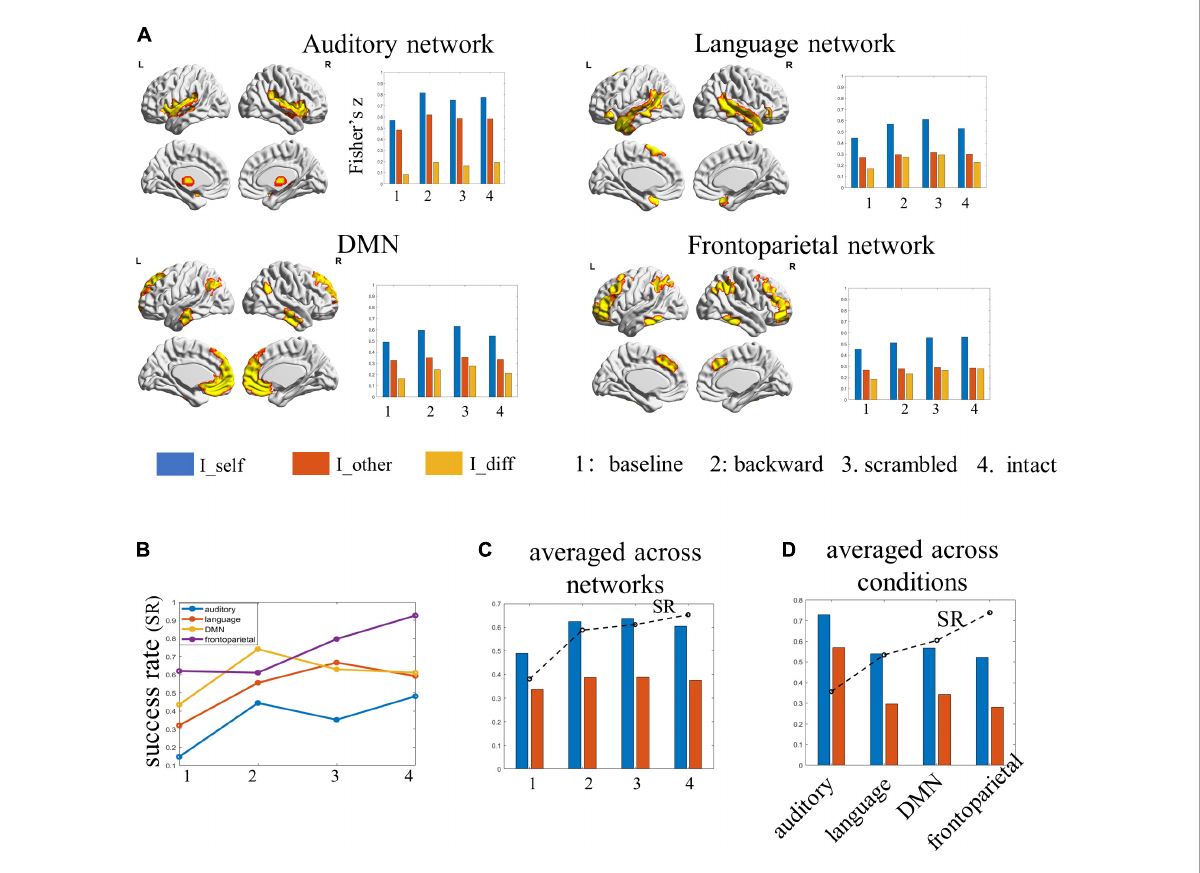
FIGURE4 The results of individual identification based on single functional networks. (A) The spatial map of the selected functional networks and the individual identifiability, within- and between-subject similarity in the FC profiles of each network. (B) The success rate of each network in identifying individuals under each condition. (C) The success rate and the within- and between-subject similarity for each condition, averaged by networks. (D) The success rate and the within- and between-subject similarities for each network, averaged by